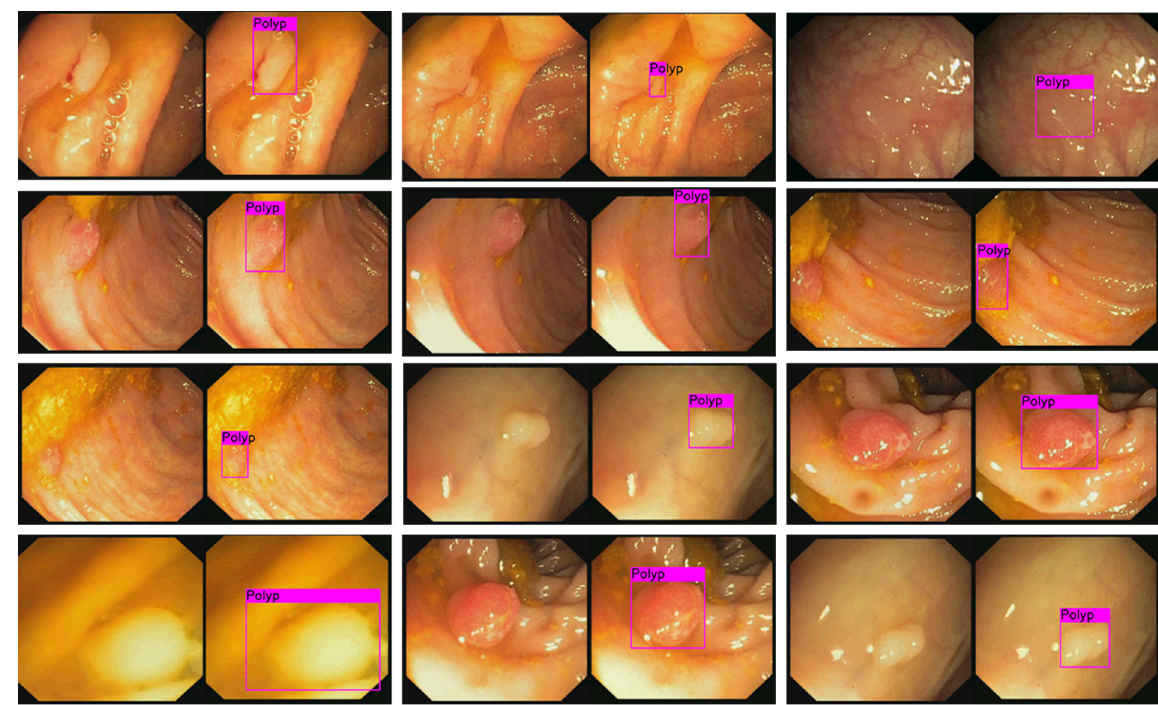
Figure 11. Pairs of original images and detected polyp images. Pink box represents the detected polyp that is the output of the automated detection model.